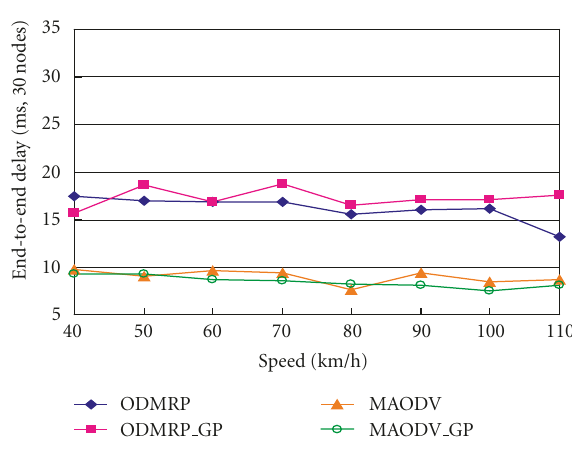
Figure 22: End-to-end delay versus mobility speed (30